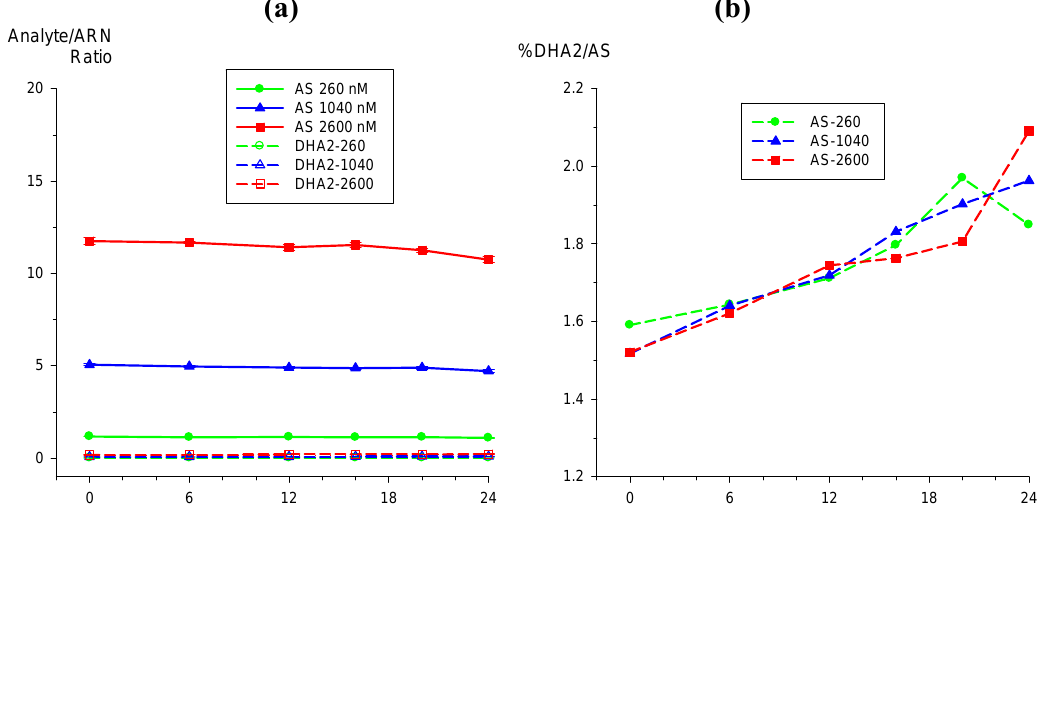
Figure 7. Post-preparative stability test of AS at 260, 1,040, and 2,600 nM in autosampler (10 °C) measured at 6 then 4 h intervals over a 24 h period showing ( a ) AS/IS and β -DHA/IS ratios and ( b ) β -DHA formation due to hydrolysis of